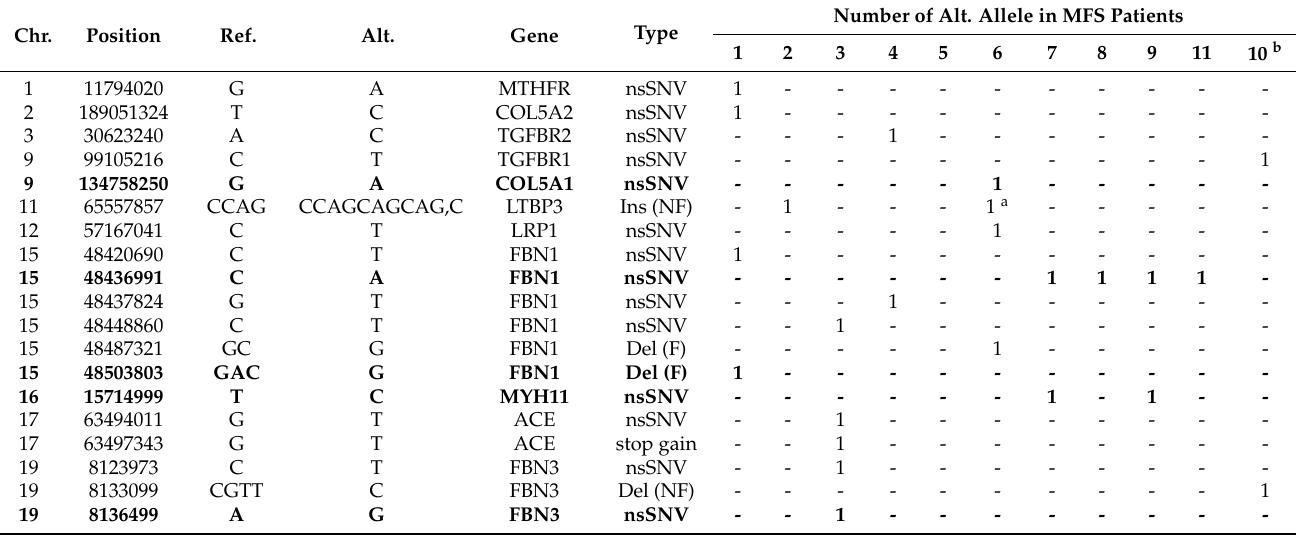
a For the second allele listed in Alt. b Healthy subject. Pathogenic variants are shown in